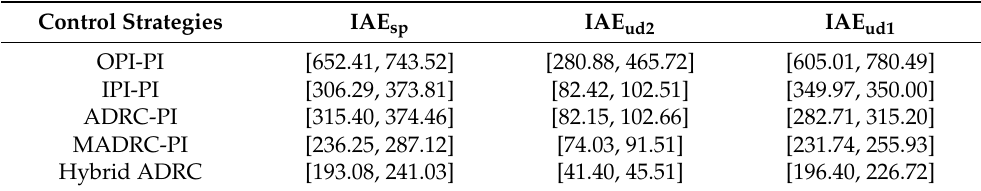
Table 3. Ranges of IAE sp , IAE ud2 and IAE ud1 of the perturbed system. Control